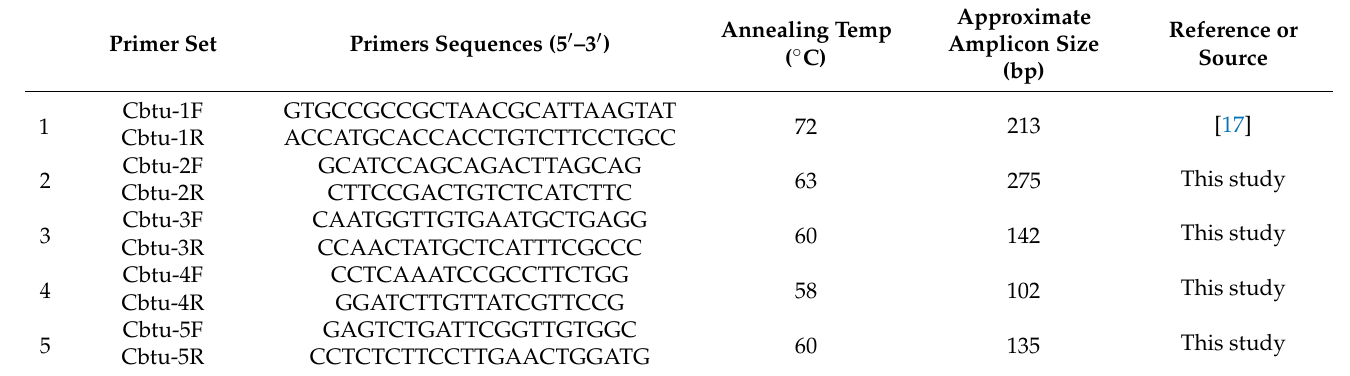
Table 1. Primer sets used to detect C. butyricum in rat